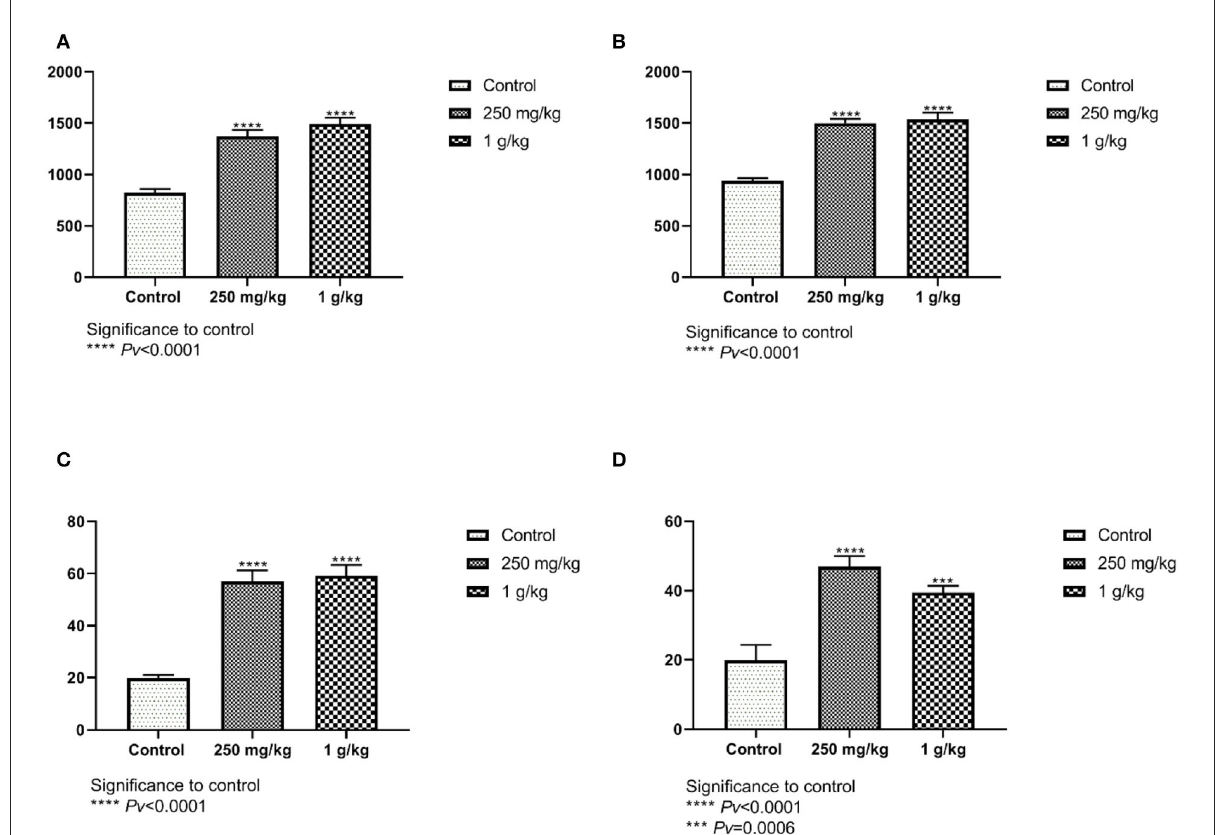
FIGURE9 (A, B) The length of the villi from the jejunum compared with the beta-glucans treatment groups to the control. (A) Females, and (B) males (n = 10 per group). (C, D) The number of goblet cells in the jejunum. Beta-glucans treatment groups compared to the control. (C) Females, and (D) males (n = 10 per group). Pv are compared to